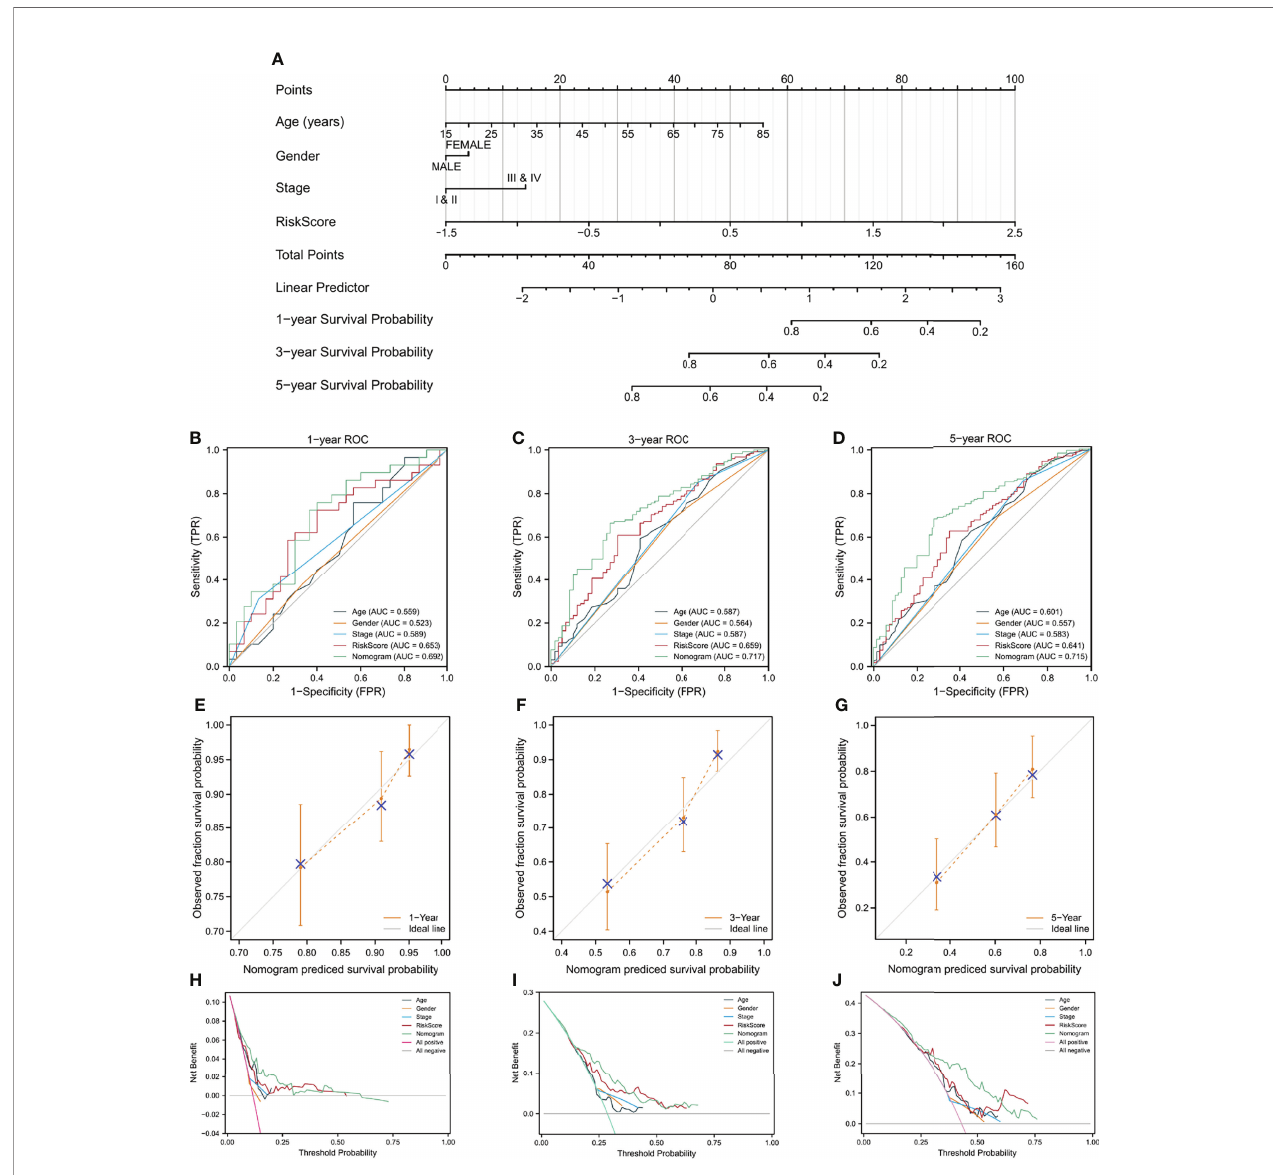
FIGURE 6 | A nomogram build on CAF-related risk score and clinicopathological characteristics related to prognosis to predict OS of HCC patients from TCGA and the veri fi cation of its accuracy. (A) The nomogram for predicting 1-year, 3-year, and 5-year OS of HCC patients. (B – D) ROC curves of the nomogram and other indicators including age, gender, stage, and risk score. (E – G) The calibration plots of the nomogram. (H – J) Decision curve analysis for evaluating the accuracy of the nomogram to predict 1-year, 3-year and 5 year OS of individuals with